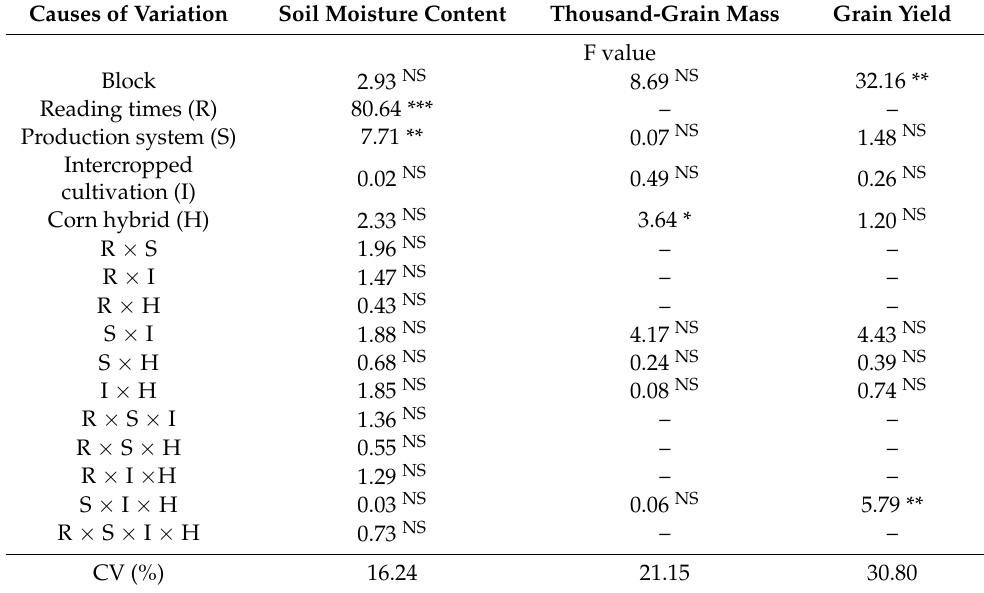
NS: not significant. *, ** and ***: Significant at 5%, 1% and 0.1%, respectively.